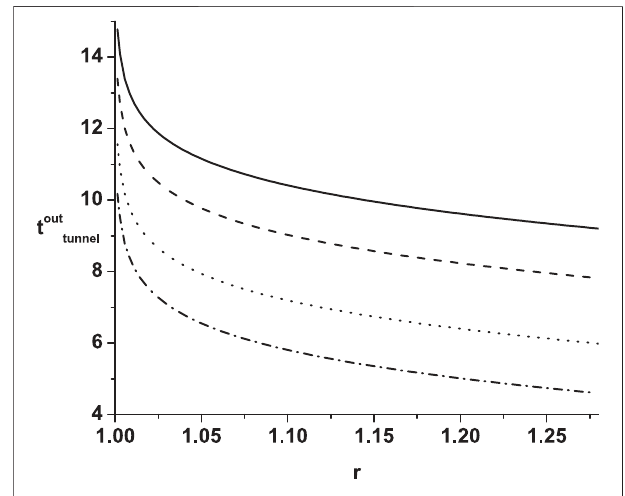
FIGURE 7 | A particle escapes from the horizon at moment t out tunnel . The tunneling time depends on the wave packet ’ s momentum uncertainty, Δ P X . The momentum uncertainty of the solid line, dashed line, dotted line and dashed-dotted line are Δ P X = 0.01, 0.05, 0.02, 0.1 respectively. The larger Δ X wavepackets are generated farther away from the horizon, so they can be generated